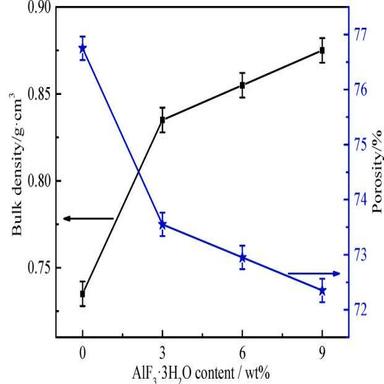
Effect of the AlF3⋅3H2O content on the porosity and bulk density of lightweight porous materials.